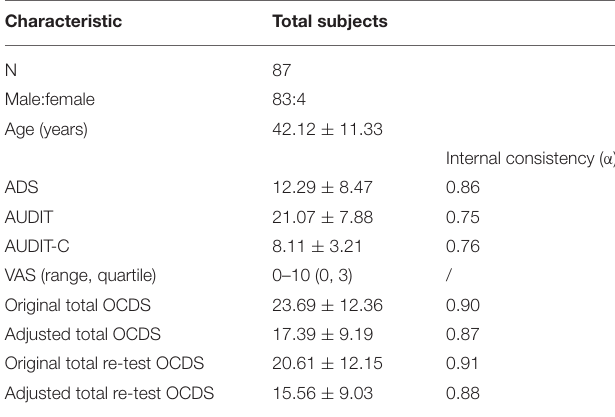
TABLE 1 | Characteristics of the participants and internal consistency of